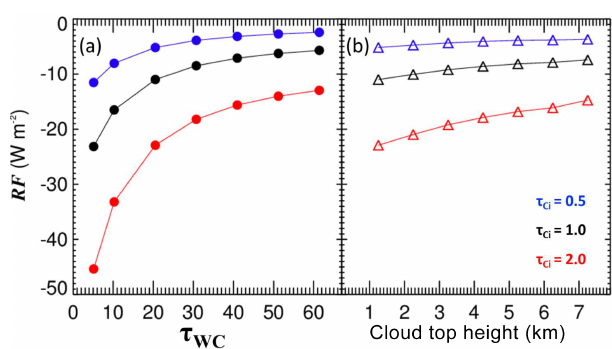
Figure 13. Integrated values of cirrus radiative forcing when a low water cloud is present. The optical thickness (left panel), and the top height (right panel) of the water cloud are varied. The colors indicate the different cirrus optical